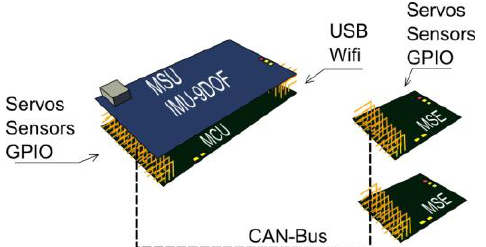
Figure 4. Schematic of the System with MSU, MSU and MSE